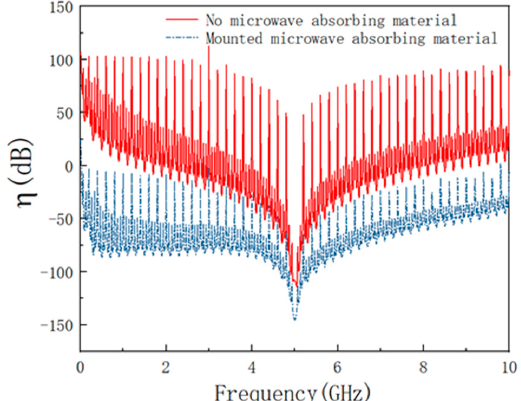
Figure 8. Coupling coefficient before and after mounting absorbing material under HPM.